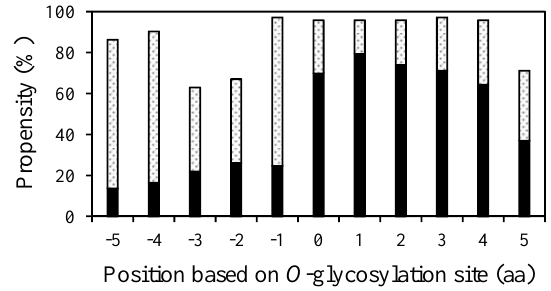
Fig. 2 b -strand and coil structure propensities around O -glycosylation sites. Black bar: b -strand structure (E, B), dotted bar: coil structure (C, S).